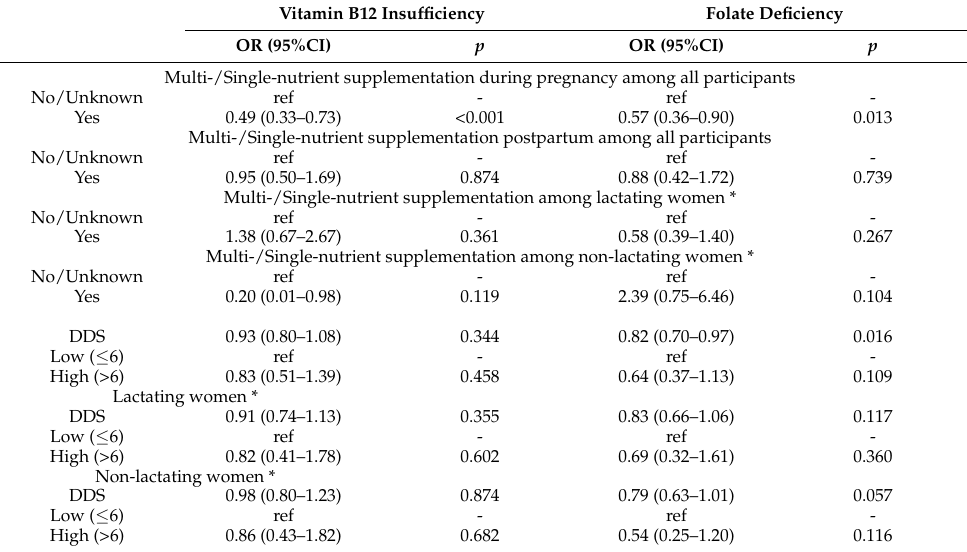
Table A2. The adjusted association of nutrient supplement and dietary diversity with vitamin B12 insufficiency and folate deficiency by multiple logistic regression